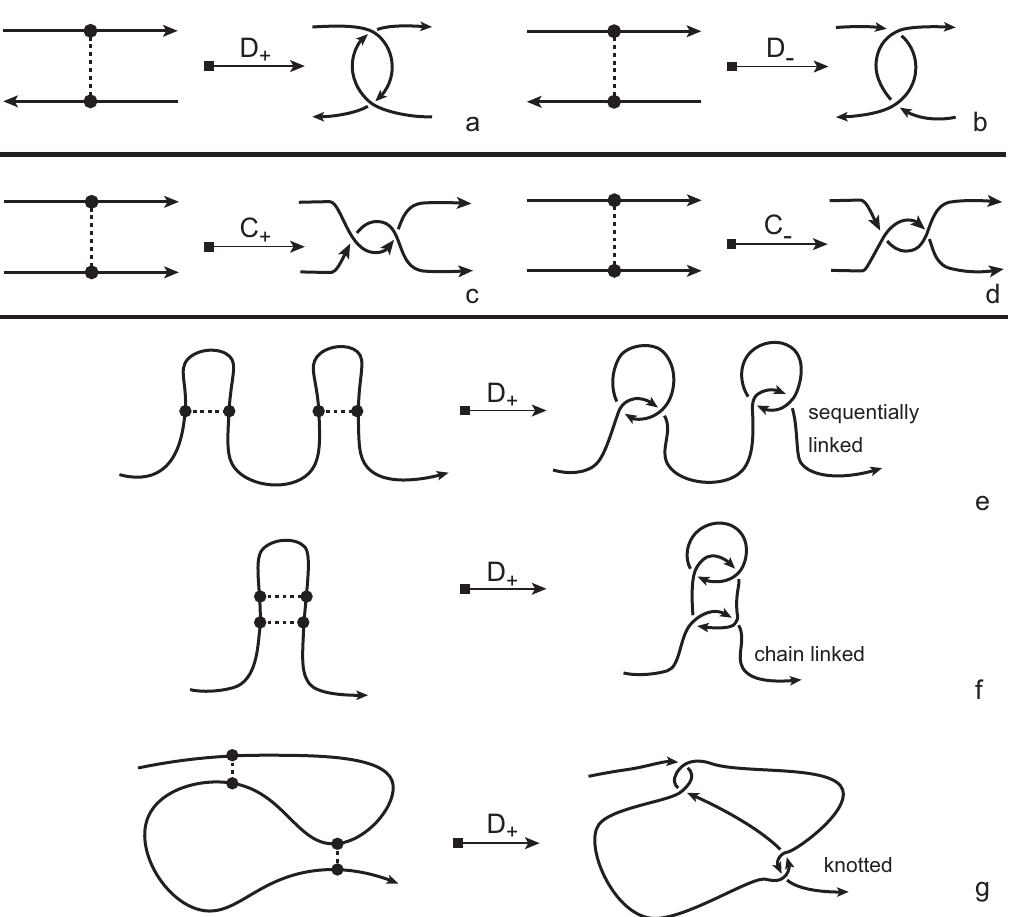
Figure 7. Type D ( a , b ), and type C ( c , d ) substitutions. Type D substitutions distinguish ( e ) sequential, ( f ) nested and ( g ) pseudoknot-like bonds by applying to the substitution a polynomial invariant for knotoids like the Turaev loop bracket polynomial or the arrow